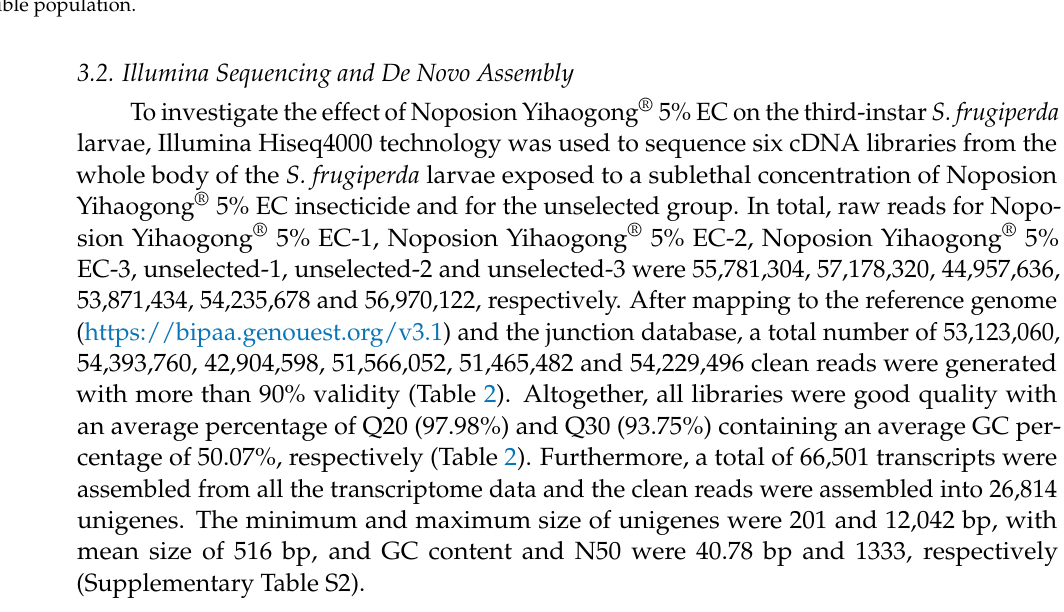
Table 2. Summary of the sequencing